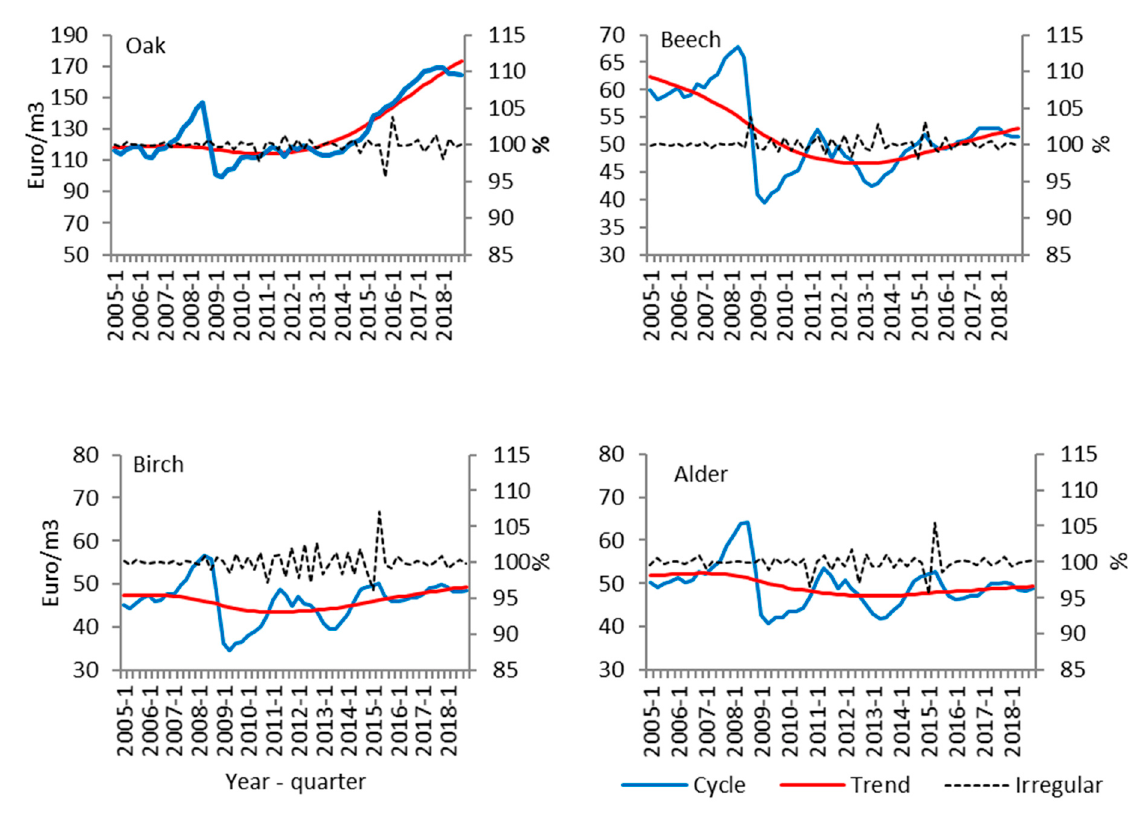
Figure 2. Irregular and cyclical fluctuations and long term trends in the prices of large-diameter timber in Poland in 2005–2018; left axis—cyclical fluctuations and long-term trends, right trend—irregular fluctuations.